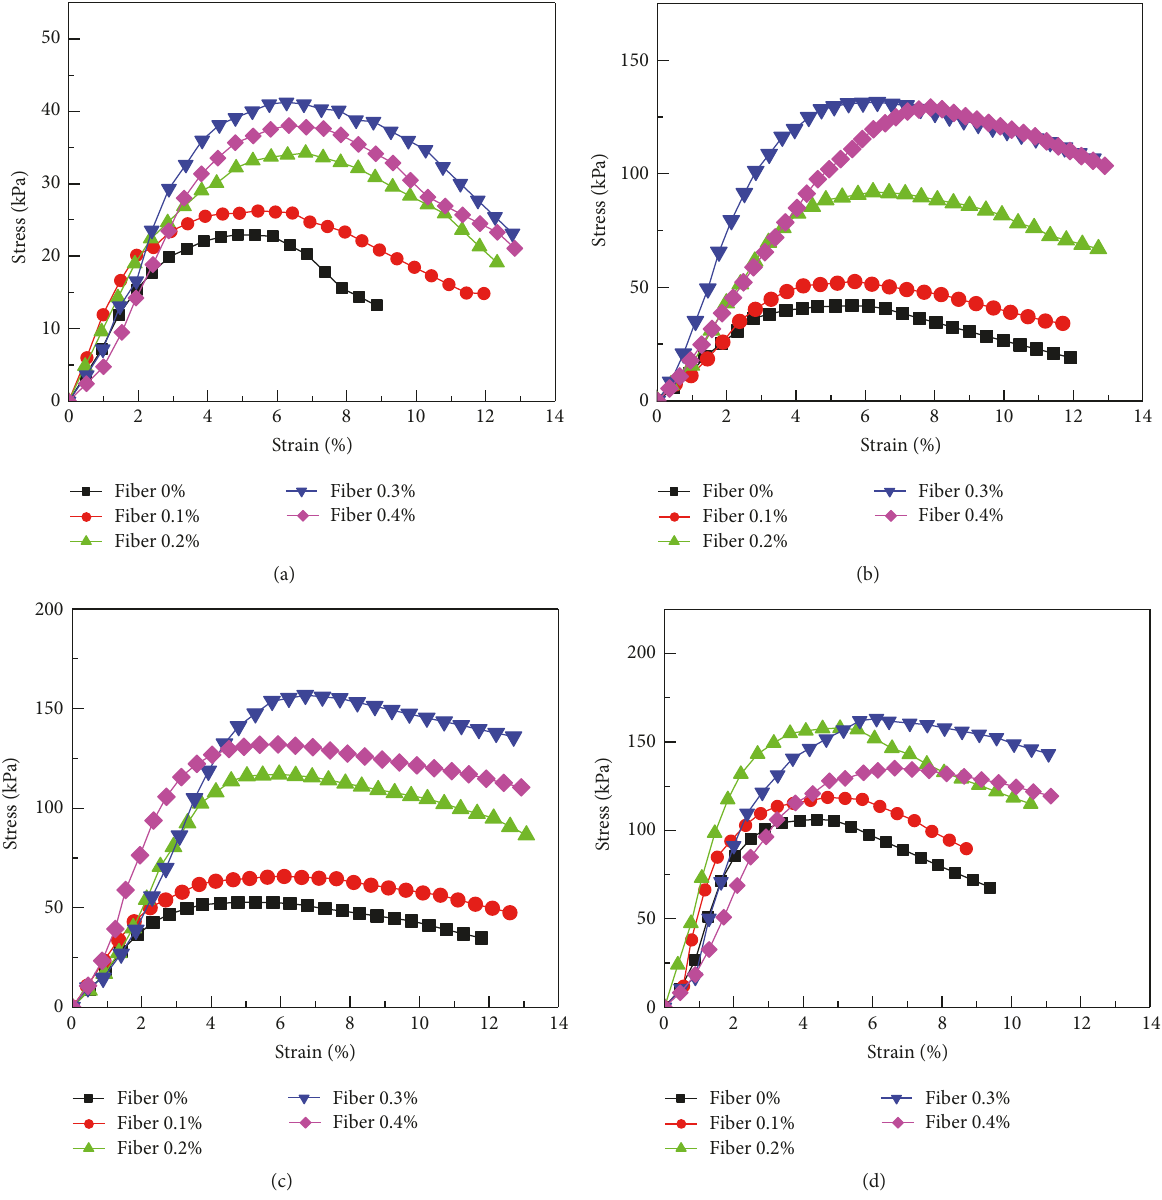
Figure 4: The strain-stress curves of unconfined compressive strengths tests. (a) Polymer 1%, (b) polymer 2%, (c) polymer 3%, and (d) polymer